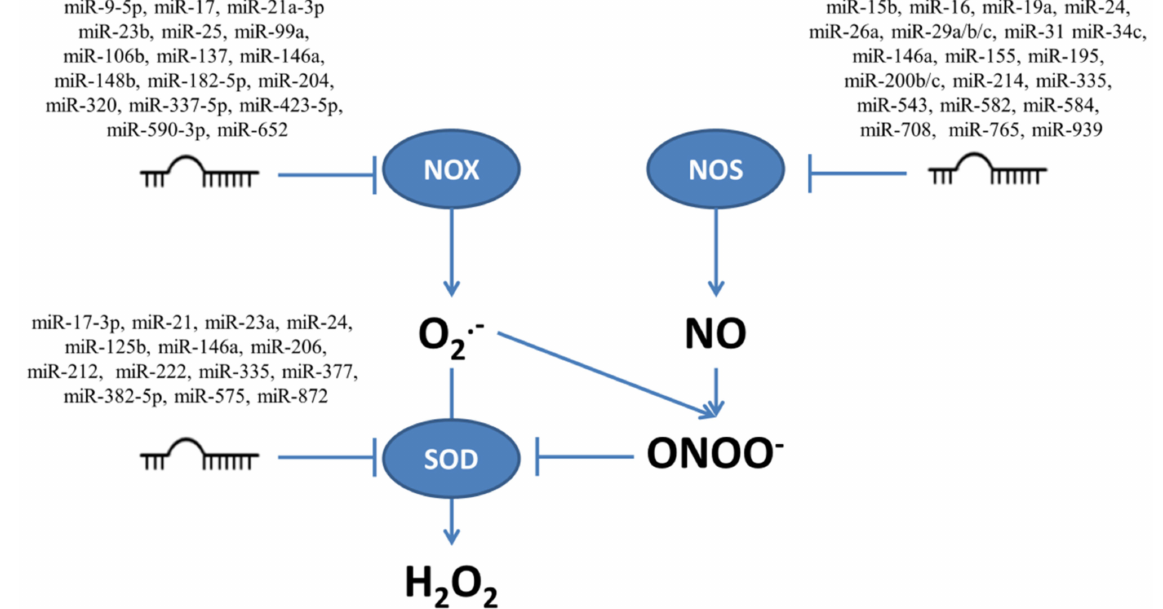
Figure 2. The multiple miRNAs which target enzymes responsible for production (NOX and NOS) and neutralization of superoxide (O 2 •− ) and nitric oxide (NO), together with superoxide dismutase (SOD) which converts O 2 •− to H 2 O 2